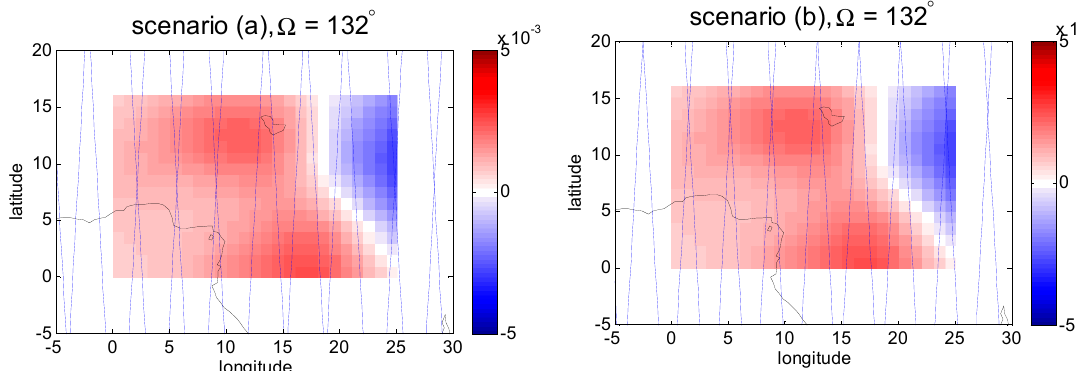
Figure 18. Groundtrack patterns over West-Africa after 6 days. Left : Scenario (a), and right : Scenario (b). From top to bottom: Ω = 0°, 116° and 132°. The sub-cycle can be seen for Ω = 116°.